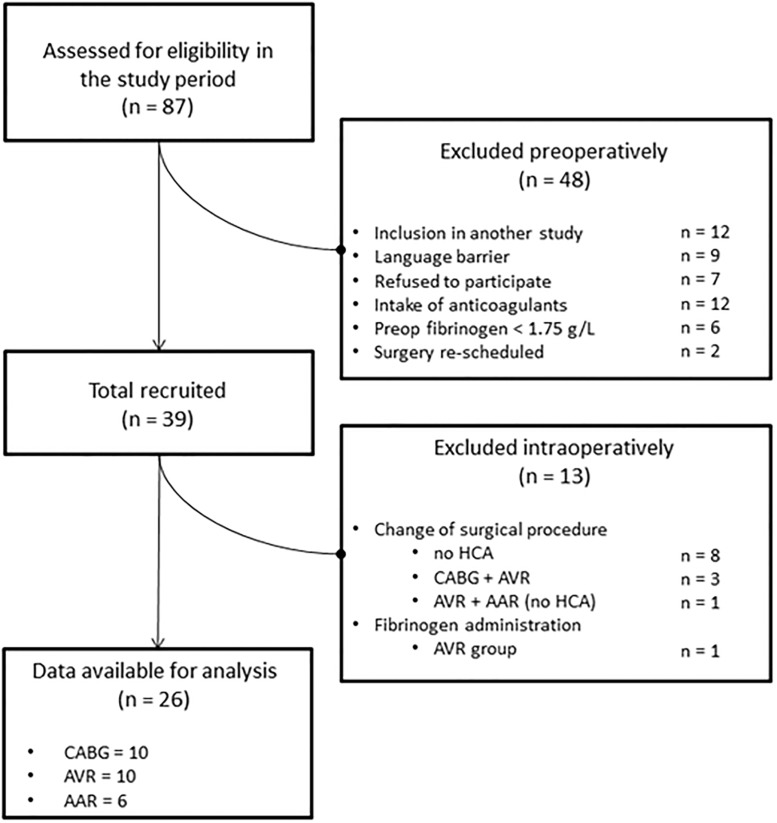
Patient flow diagram.CABG = coronary artery bypass grafting; AVR = aortic valve replacement; AAR = ascending aorta replacement; HCA = hypothermic circulatory arrest. n indicates number of patients.